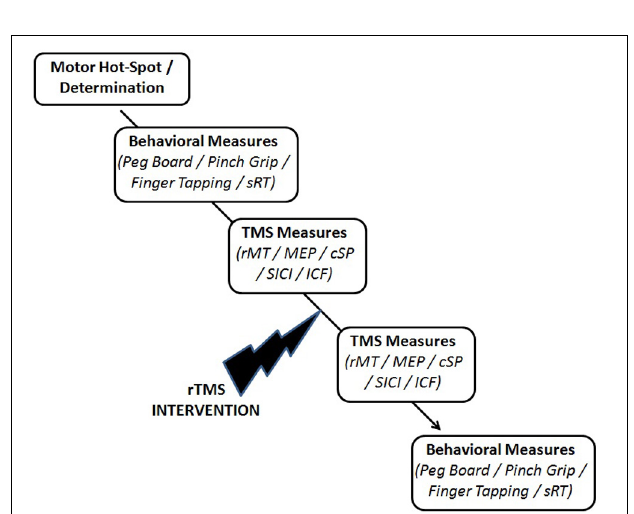
23 years); Right: older subject (aged 60 years). (B) Region of interest (ROI) selected for the correlation analysis of cortical thickness and motor evoked potentials. M: Medial; A: Anterior; P: Posterior; L: Lateral.